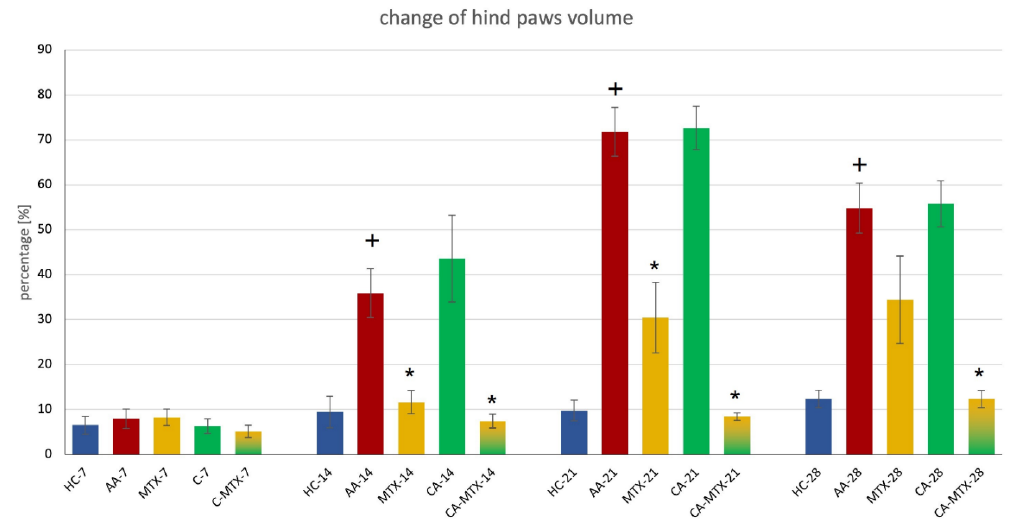
Figure 2. Change in the volume of the hind paws on the 7th, 14th, 21st, and 28th day. + HC vs. AA, * AA vs. MTX/CA/CA-MTX, p ≤ 0.05.